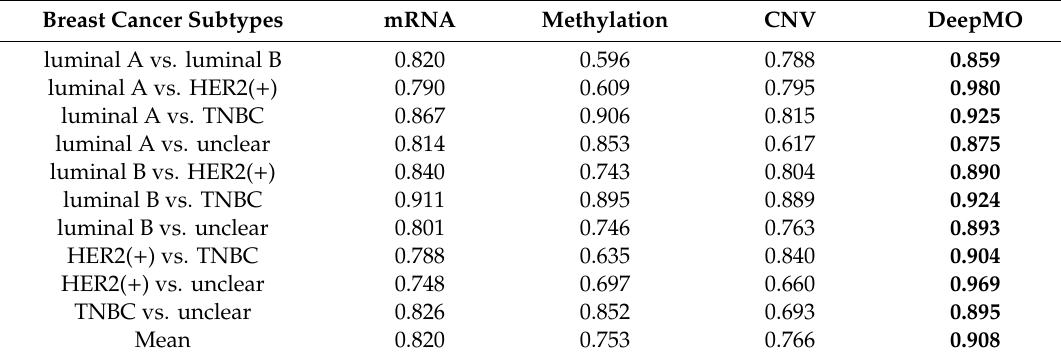
Table 4. The accuracy of any two breast cancer subtypes with di ff erent types of omics data and multi-omics data by DeepMO. Bold numbers are the best performance of binary classification.